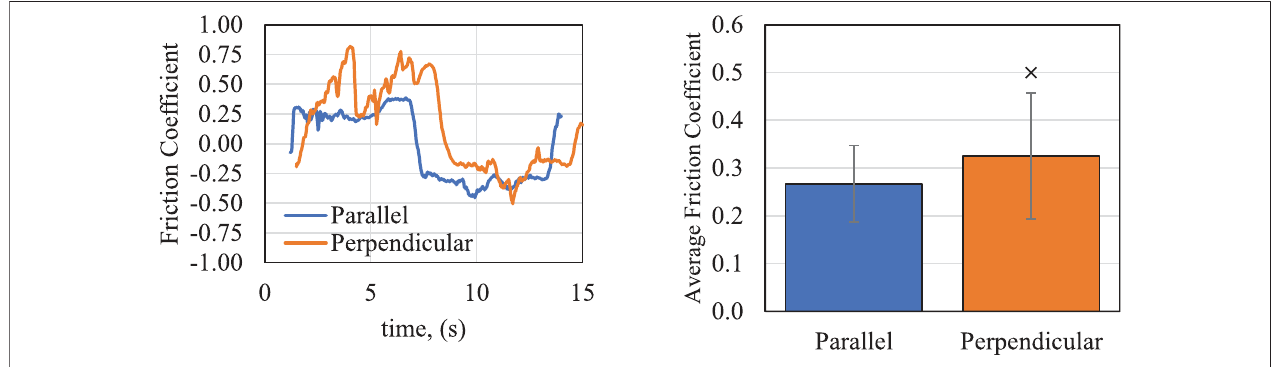
FIGURE6| (Left)Instantaneousfrictioncoef fi cientforpineparticle(S4)slidinginparalleldirectionandperpendiculardirectionand(right)averagefrictioncoef fi cient.